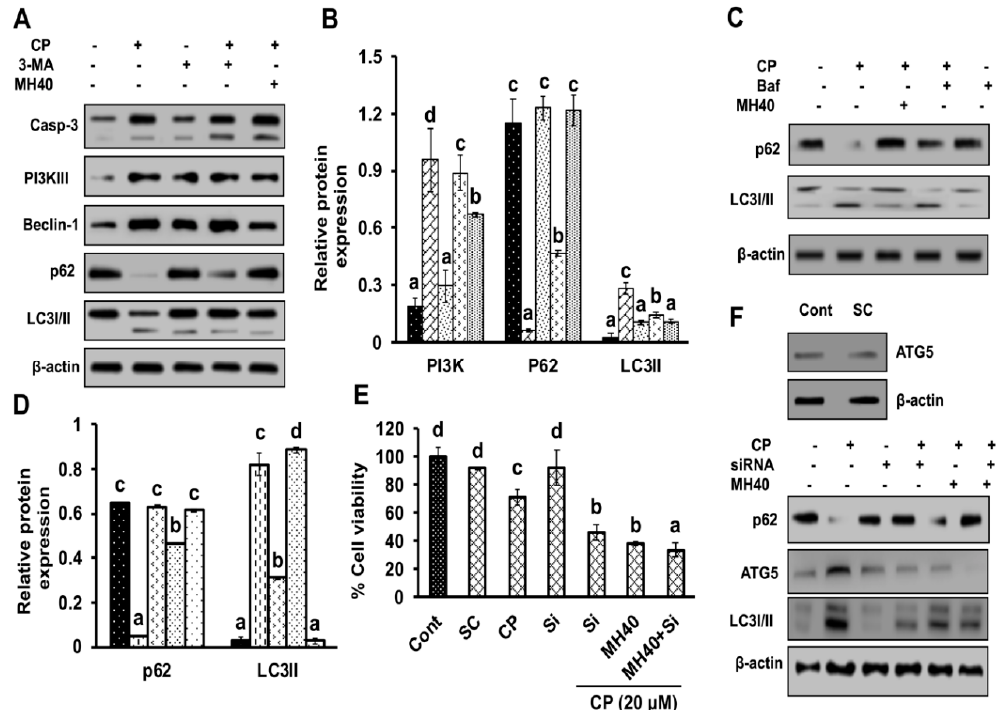
Figure 9. Inhibition of autophagy by 3-MA, baf, Atg5-siRNA and Mh enhances the sensitivity of HepG2 cells to CP. ( A ) Western blot analysis of autophagy and apoptotic markers was done using specific antibodies against Casp-3, PI3KIII, Beclin-1, p62 and LC3I/II after treatment with CP, MH and 3-MA alone and in combination. β -actin was used as an internal loading control. ( B ) Relative expression of PI3KIII, p62 and LC3I/II analyzed by densitometry analysis using ImageJ software. ( C ) The expression level of p62 and LC3I/II was analyzed after treatment with CP, MH and baf alone and in combination. Results are normalized to β -actin in respective controls. ( D ) Relative expression of p62 and LC3I/II analyzed by densitometry analysis using ImageJ software. ( E ) Cell viability of HepG2 cells was analyzed by MTT assay after treatment with CP, MH and Atg5-siRNA. ( F ) The expression level of p62, Atg5 and LC3I/II was analyzed after treatment with CP, MH and Atg5-siRNA alone and in combination. Results are normalized with β -actin in respective controls. The data are presented as the means standard deviation ( n = 3). Values with different letters (a–d) differ significantly from each other ( p < 0.05).